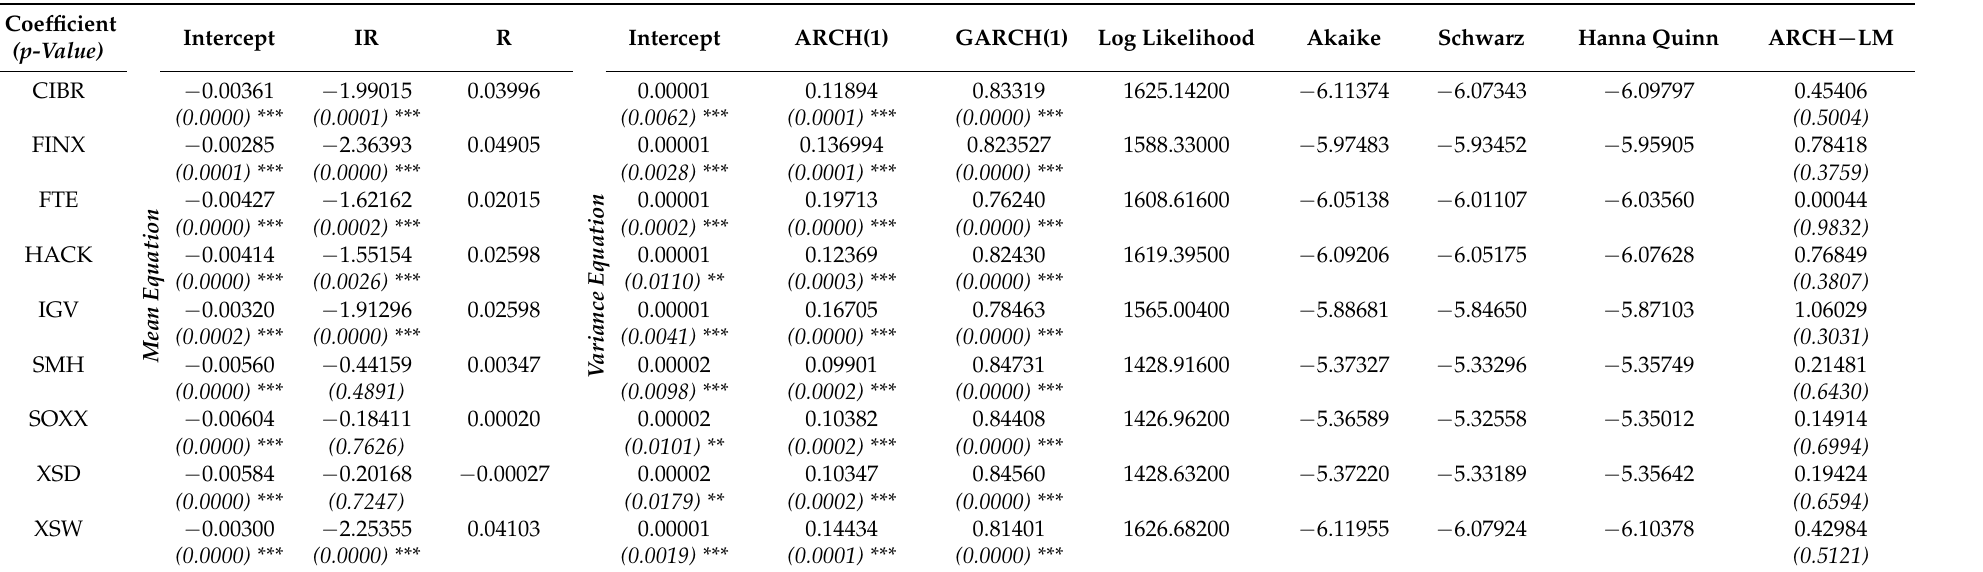
Table A10. GARCH (1,1) model of ETF idiosyncratic risk and excess